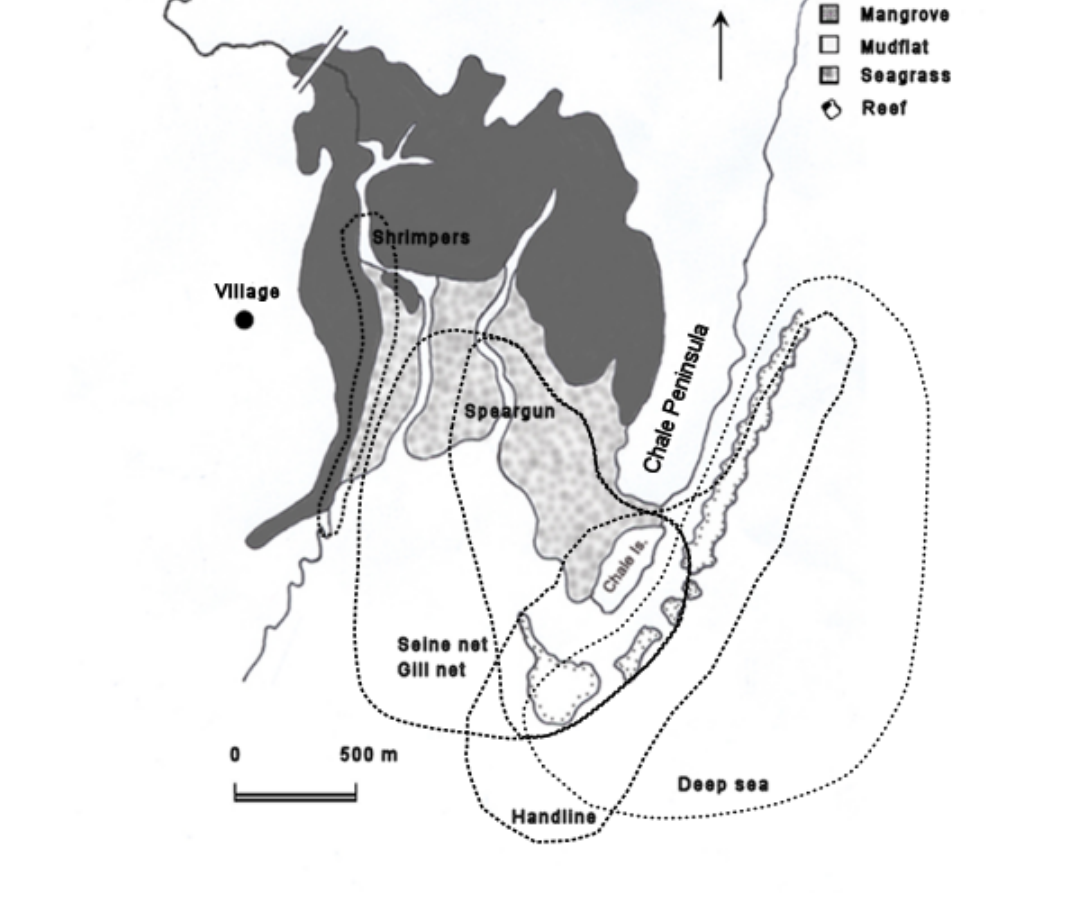
Fig. 2. Map of the coastal seascape in focus. The respective distribution of mangroves, mudflats, seagrass beds, and reefs is indicated. The area of primary fishing effort for each fishing related occupational category is marked with dotted lines showing the geographical distribution of fishing areas at a local scale. The occupational categories associated with each area are indicated in the